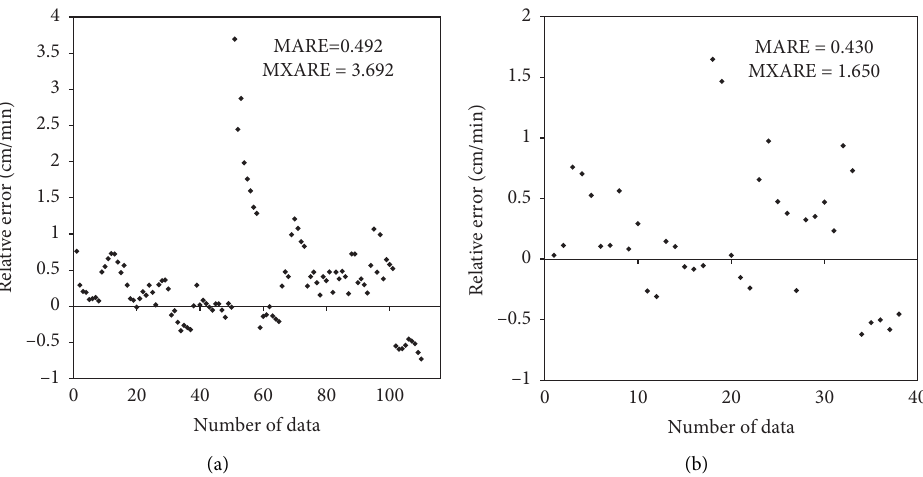
MARE=0.492 MXARE = 3.692